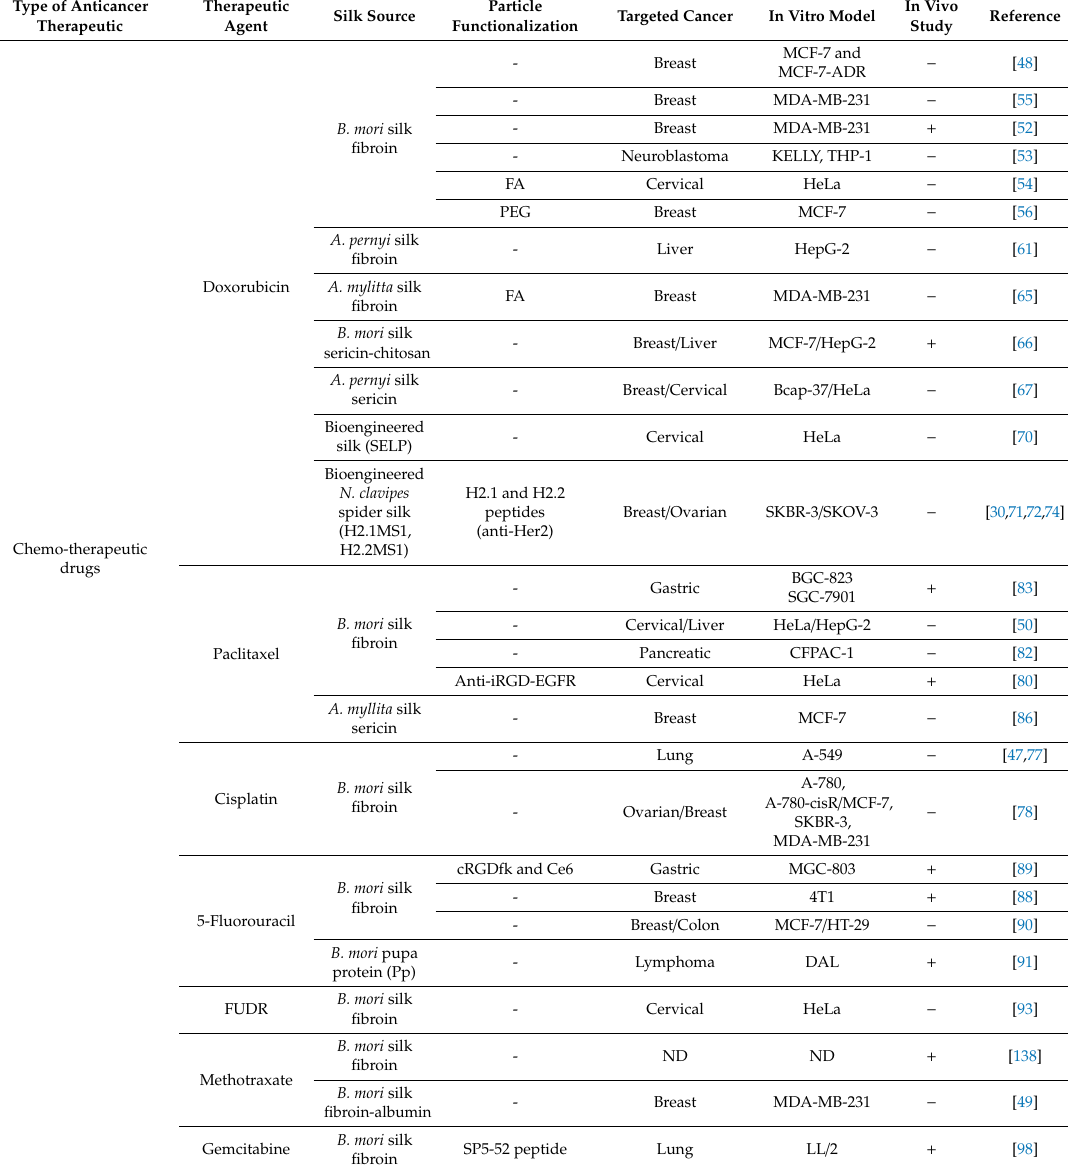
Table 1. Delivery of various anti-cancer therapeutic agents using silk-based